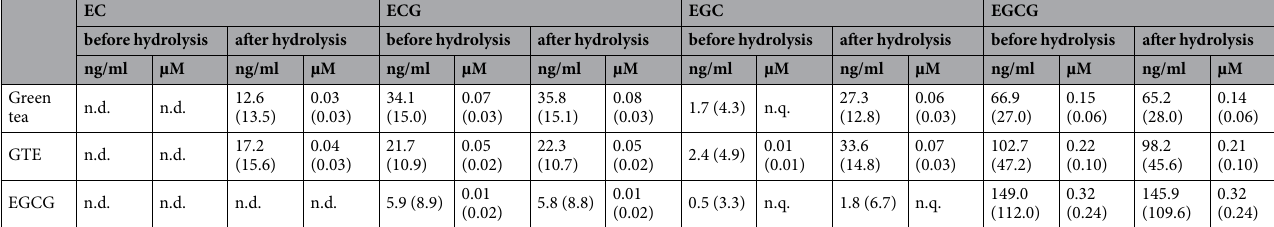
Table 4. Catechin plasma levels before and after hydrolysis (deconjugation) 2 hours after interventions. EC, epicatechin; ECG, epicatechin gallate; EGC, epigallocatechin; EGCG, epigallocatechin gallate; n.d. not detectable; n.q. not quantifiable. Data are mean (SD) from n = 50 subjects for green tea and EGCG and n = 49 for GTE.